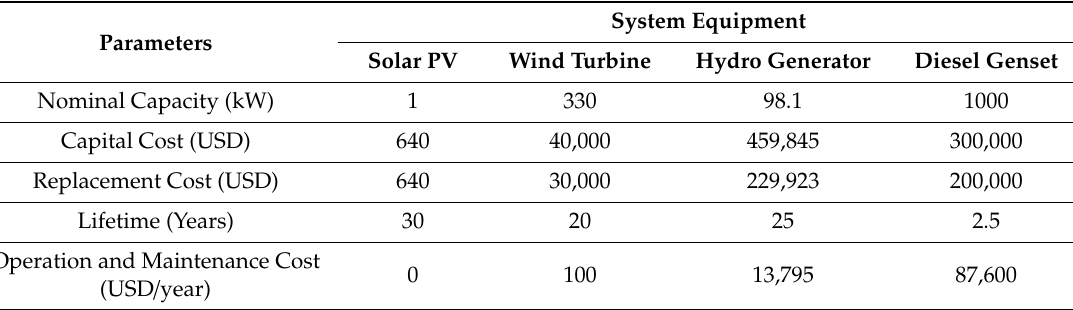
Table 3. Specifications of some system